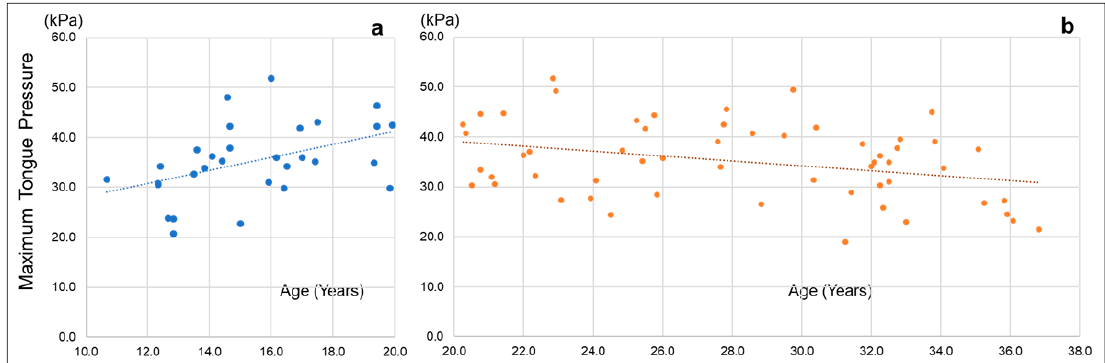
Figure 3. Correlation between MTP and age in two age groups. ( a ) Group under 20. ( b ) Group over 20.